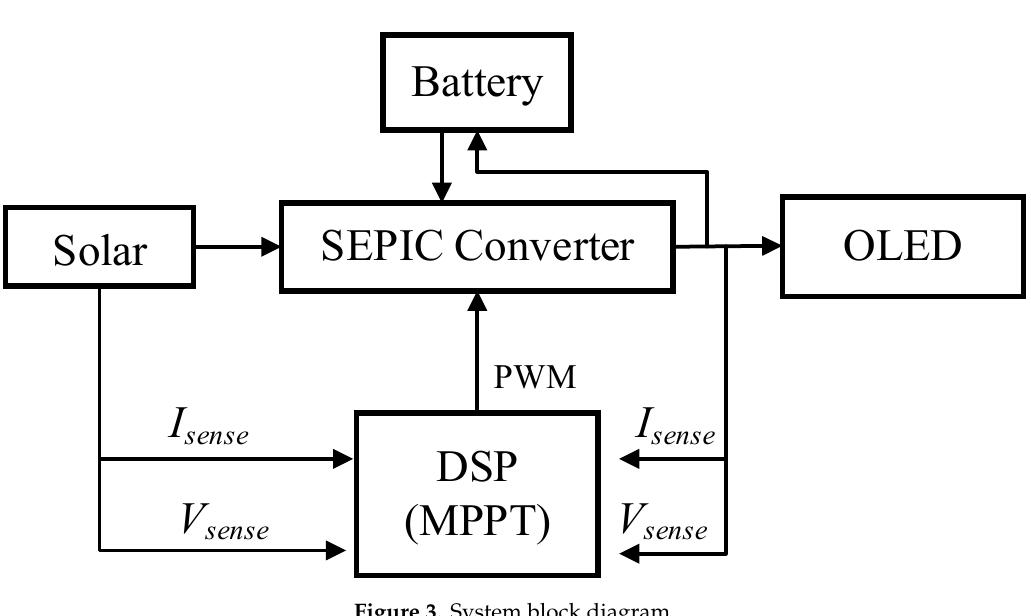
Figure 3. System block diagram.